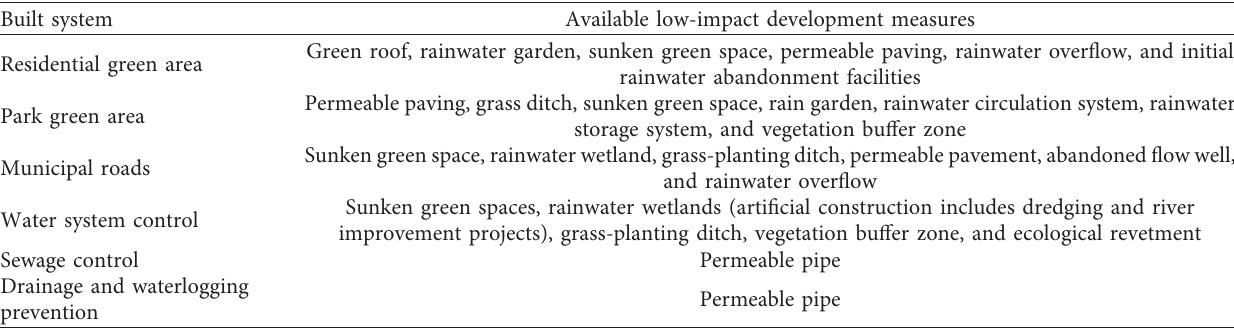
Table 3: Selection of sponge renovation measures for different buildings.